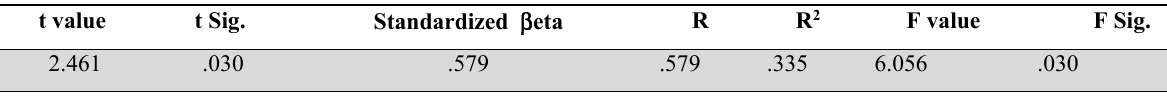
Results of simple linear regression to test the impact of board of directors’ independence effect on return on assets (ROA) indicator value